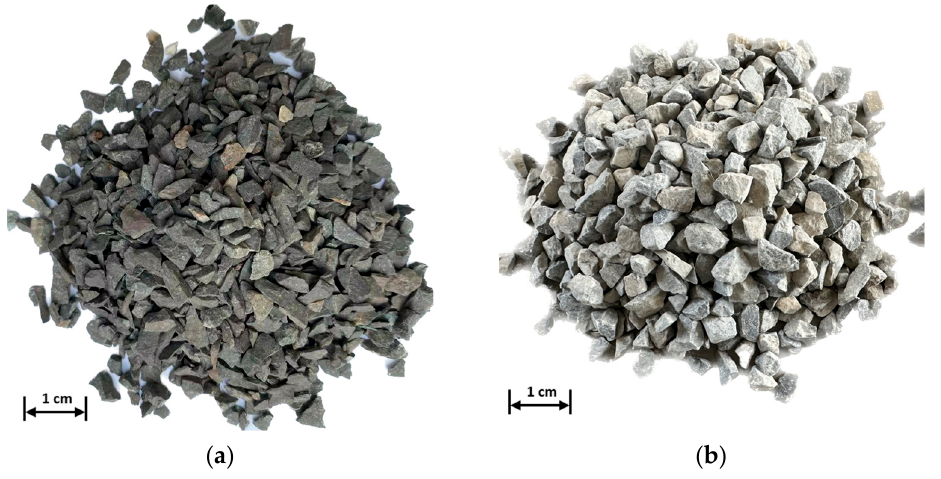
Figure 1. Aggregates: ( a ) Magnetite and ( b ) limestone. Table 2. Basic physical performance of the aggregates.